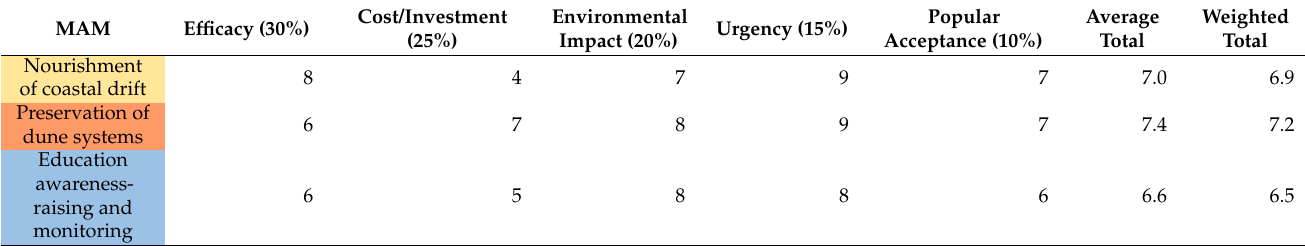
Table 5. Multi-criteria analysis performed by Group 1 for each MAM using their 5 elected criteria and respective importance for the weighted calculation. The colored cells represent nourishment (yellow), management (orange), and adaptation (blue) measures